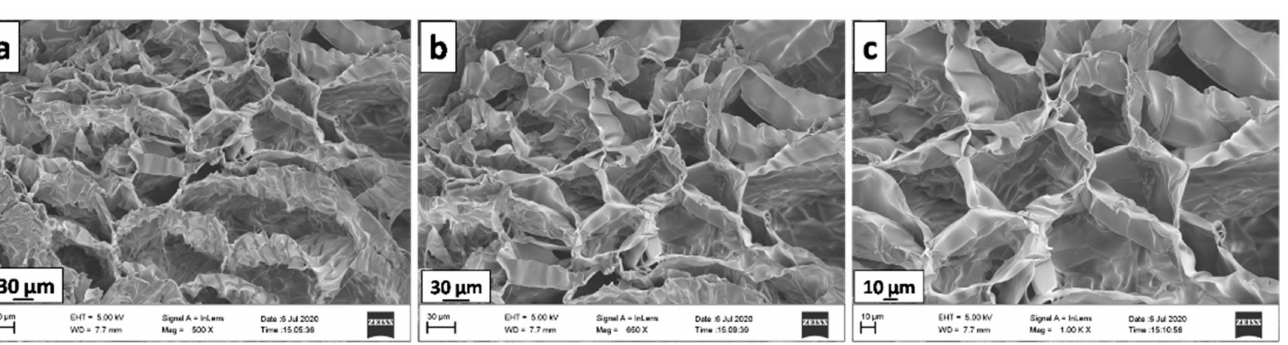
Figure 3. Scanning electron Microscopy (SEM) images of Kg-Ch sponge at different Magnifications. ( a ) 500X, scale 30 µ m, ( b ) 650 X, scale at 30 µ m, ( c ) 1000 X, scale 10 µ